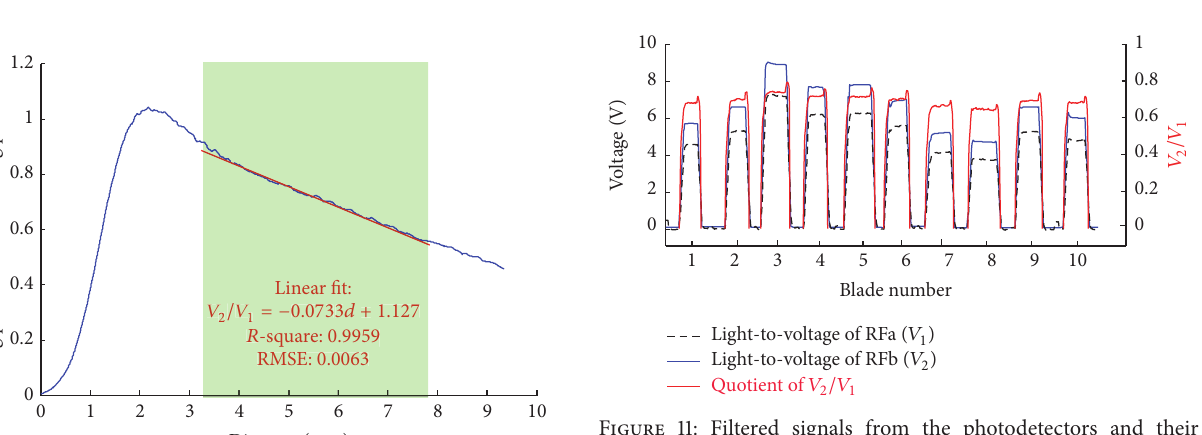
Figure 11: Filtered signals from the photodetectors and their quotient at a working point of 0RPM.